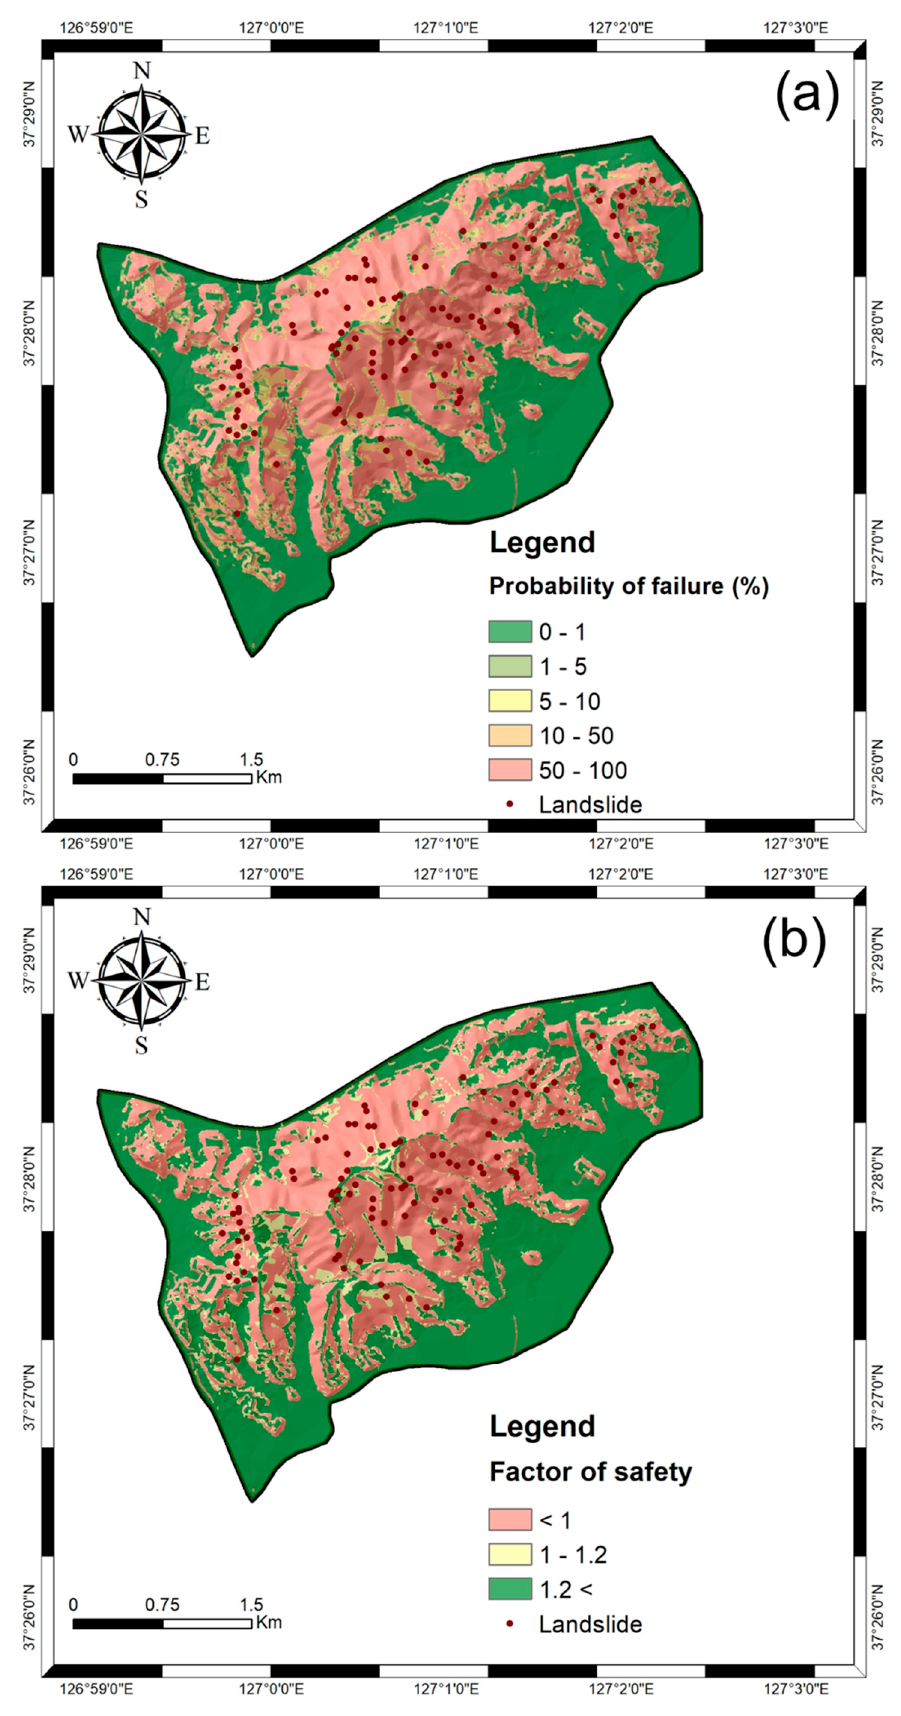
Figure 9. Map showing ( a ) the probability of failure evaluated using Monte Carlo simulation and ( b ) the factor of safety evaluated using the deterministic analysis.